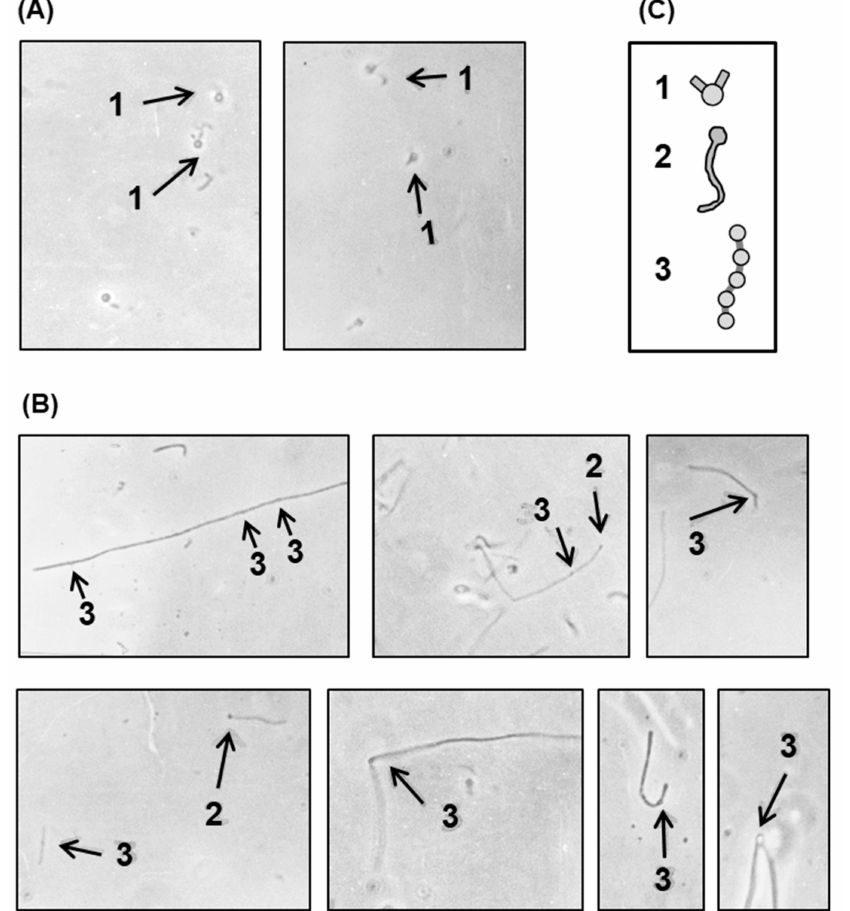
Figure 9. Bacteria were grown in the presence of penicillin as described above, and photomicrographs of nonlysogen ( A ) and polylysogen ( B ) cells were taken. The various shapes are sketched for ease of recognition ( C ) and marked by numbers, as follows: 1, rabbit ear shape terminal bulge; 2, terminal bulge; 3, internal bulge. Magnification = 475 ×